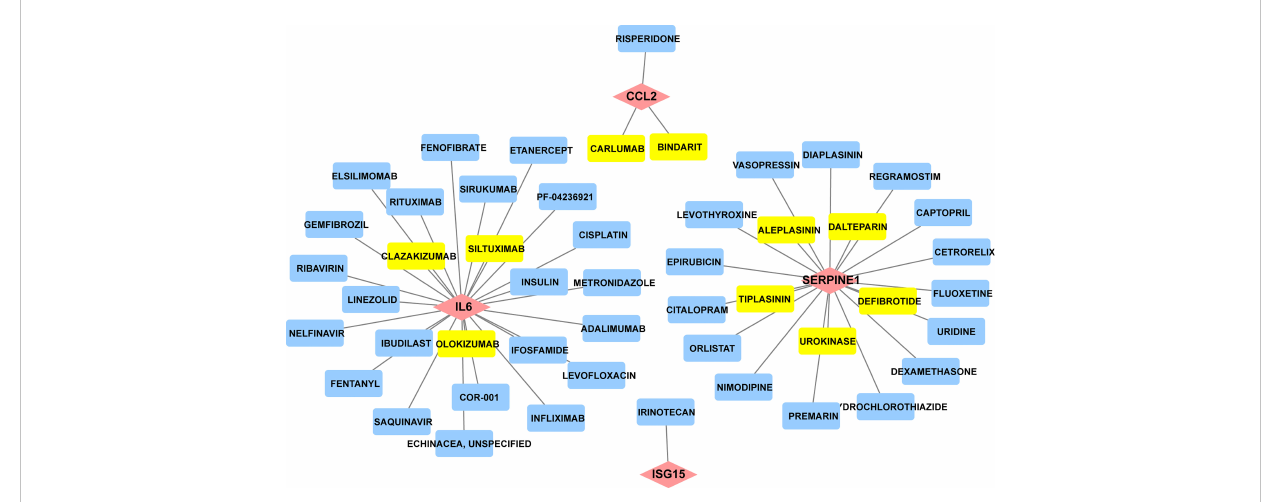
FIGURE 9 Constructed the network of drug-gene interactions. The pink diamonds represent the hub genes, yellow round rectangle represent the top ten drugs with the highest scores, blue round rectangle represent other potential drugs. The scores of potential drugs identi fi ed by the DGIdb show the importance of drugs, with a higher score indicating greater importance.